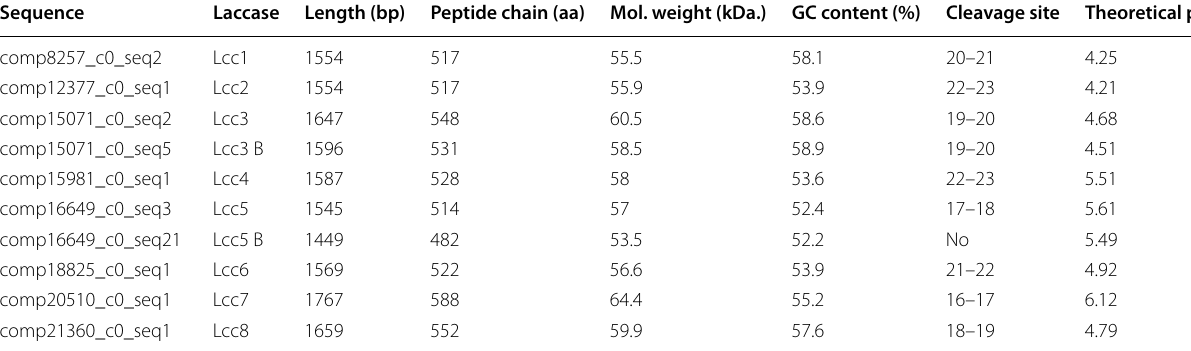
Table 1 Complete characterization of laccase-codifying transcripts from Peniophora sp. CBMAI 1063 Sequence Laccase